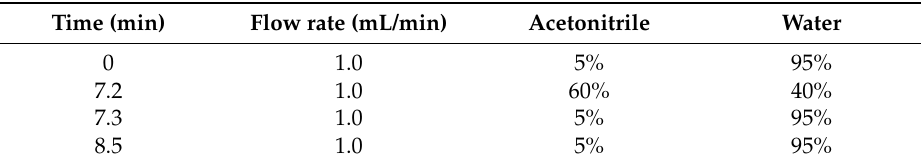
Table 1. HPLC gradient method for